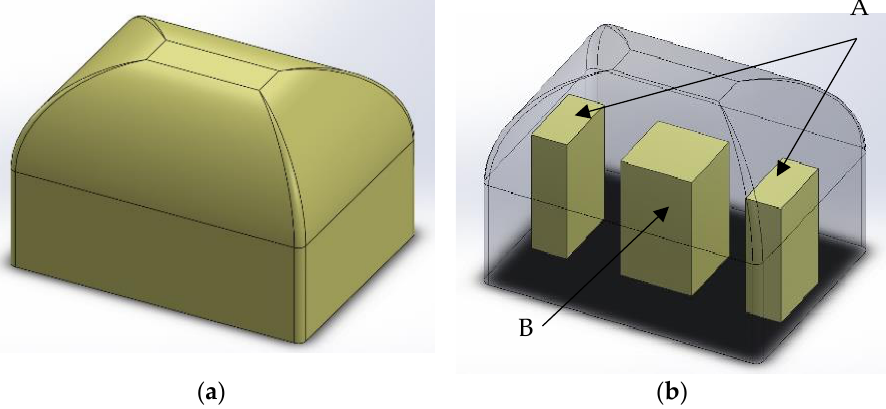
Figure 2. A 3D schematic model of sample location in a foam block. ( a ) Manufactured block; ( b ) localization of specimens.